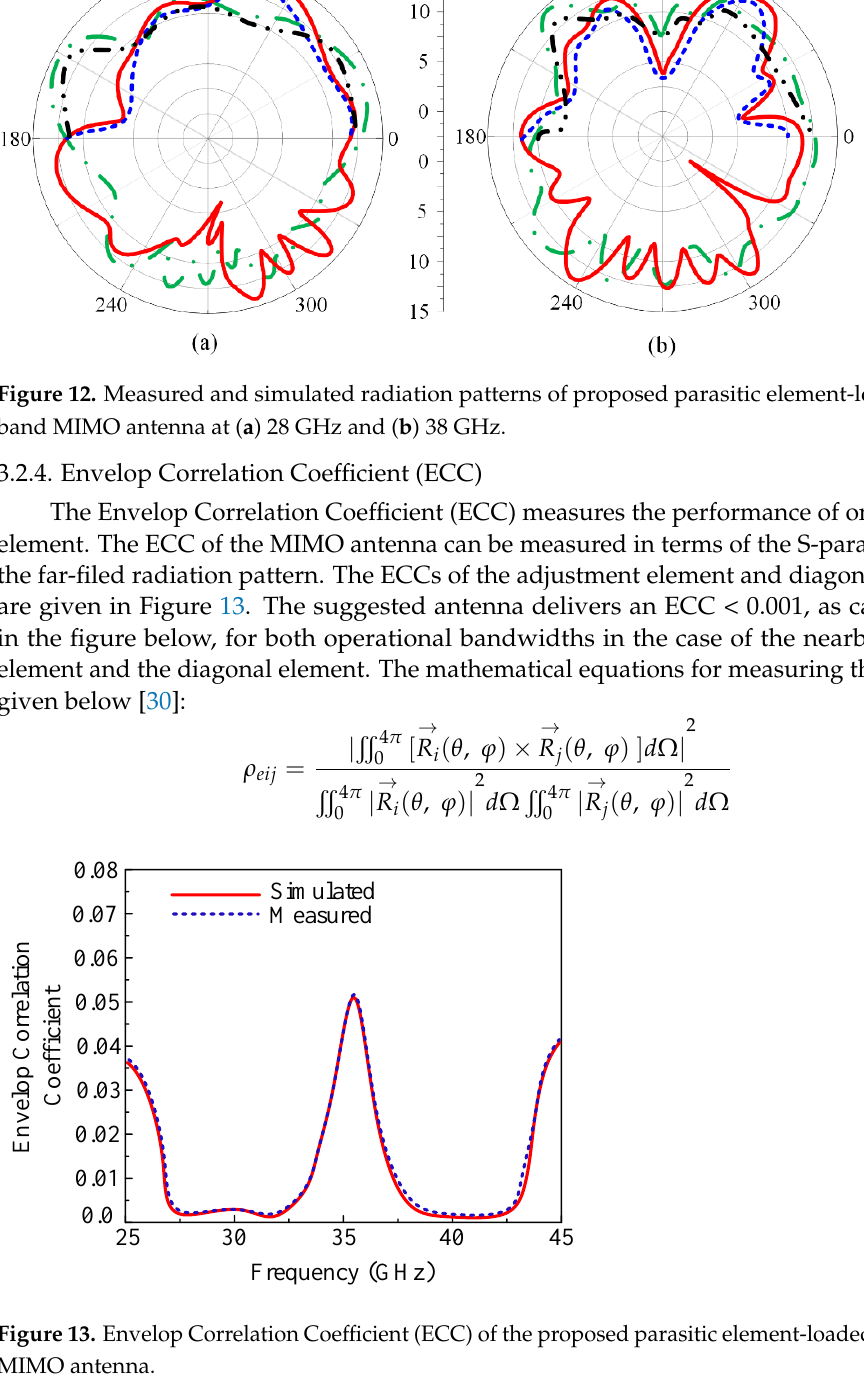
Figure 14. Diversity Gain (DG) of the proposed parasitic element-loaded dual-band MIMO an- tenna. 3.2.6. Channel Capacity Loss (CCL) To check the performance of the MIMO antenna system, Channel Capacity Loss (CCL) is at the leading edge. CCL occurs in the MIMO system due to correlation losses. The proposed parasitic element-loaded four-port MIMO antenna offers around 0.01 bps/Hz for both operating bandwidths of 28 GHz and 38 GHz, as provided in Figure 15. The acceptable range of CCL is <0.5 bps/Hz, and the mathematical equation to calculate it is given below [31]: 𝐶 𝐿𝑜𝑠𝑠 = −𝑙𝑜𝑔 2 det [∝ 𝑅 ] (8) where